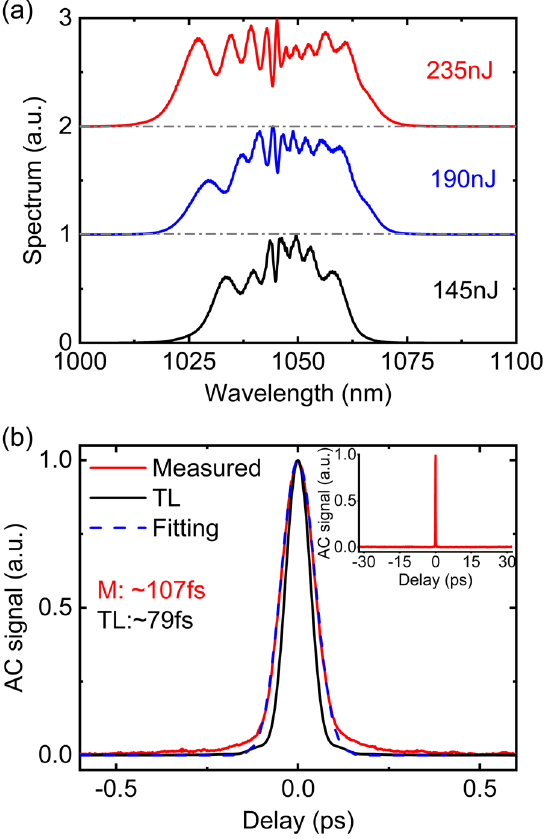
Figure5: (a)Experimentallymeasuredspectrawithincreasingpulse energy. (b) The measured AC trace (red curve) of the compressed pulse at the maximum pulse energy of 235nJ and the comparison withtheGaussian-fit(bluedashcurve)andthecalculatedACtraceof the transform-limited (TL) pulse (black curve). Inset: The measured intensity AC trace with 60 ps